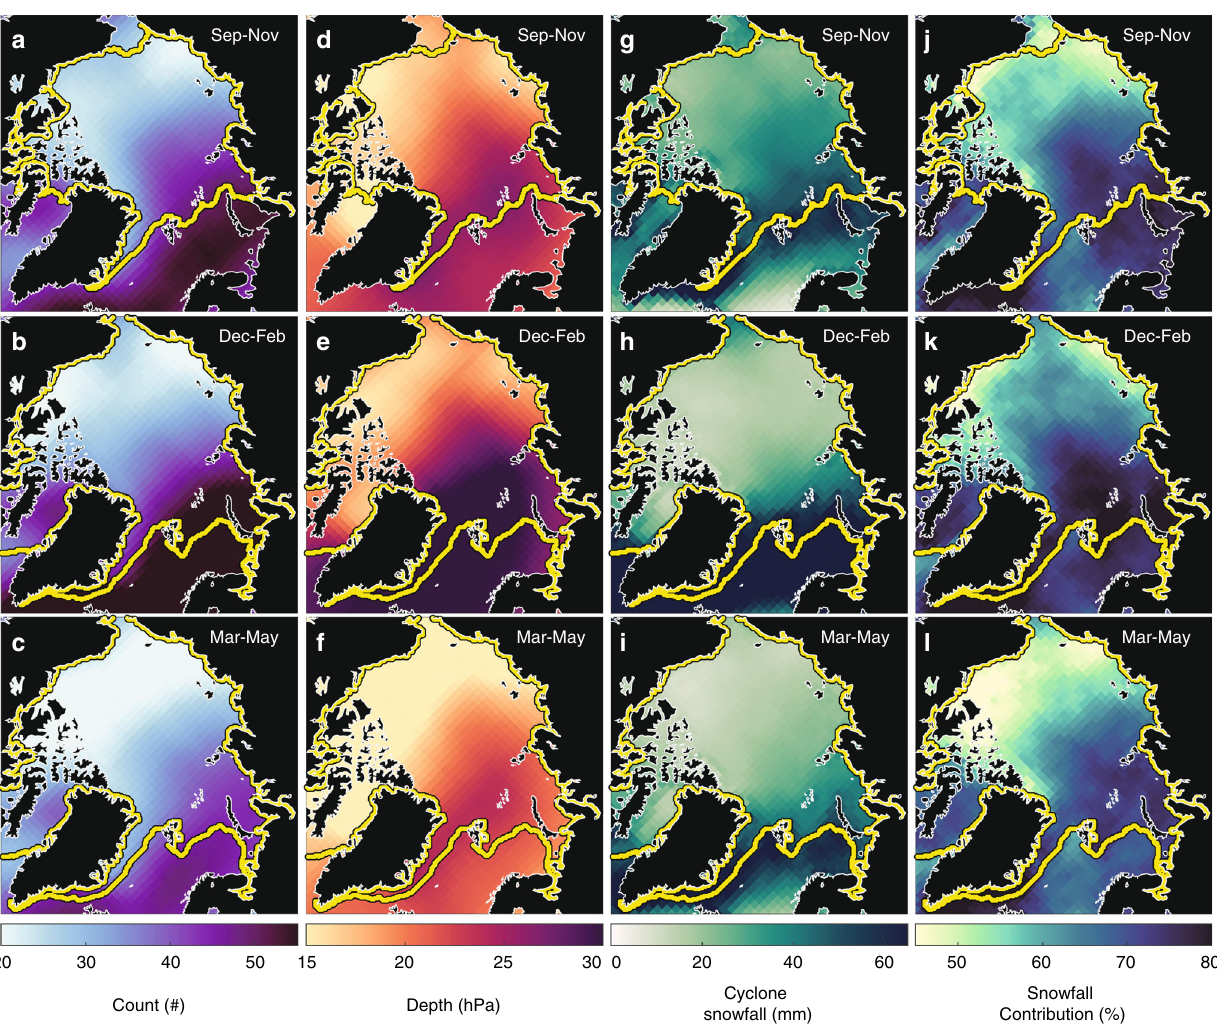
Fig. 2 The 1979 – 2016 seasonal average of cyclone variables. Climatological average in: a – c cyclone event count, the number of times a grid cell is encompassed by a cyclone ’ s area; d – f cyclone depth, a metric for cyclone intensity that takes into account cyclone size and intensity; g – i cyclone-snowfall amount; and j – l cyclone-snowfall contribution, the percent contribution of snowfall from cyclones relative to the total